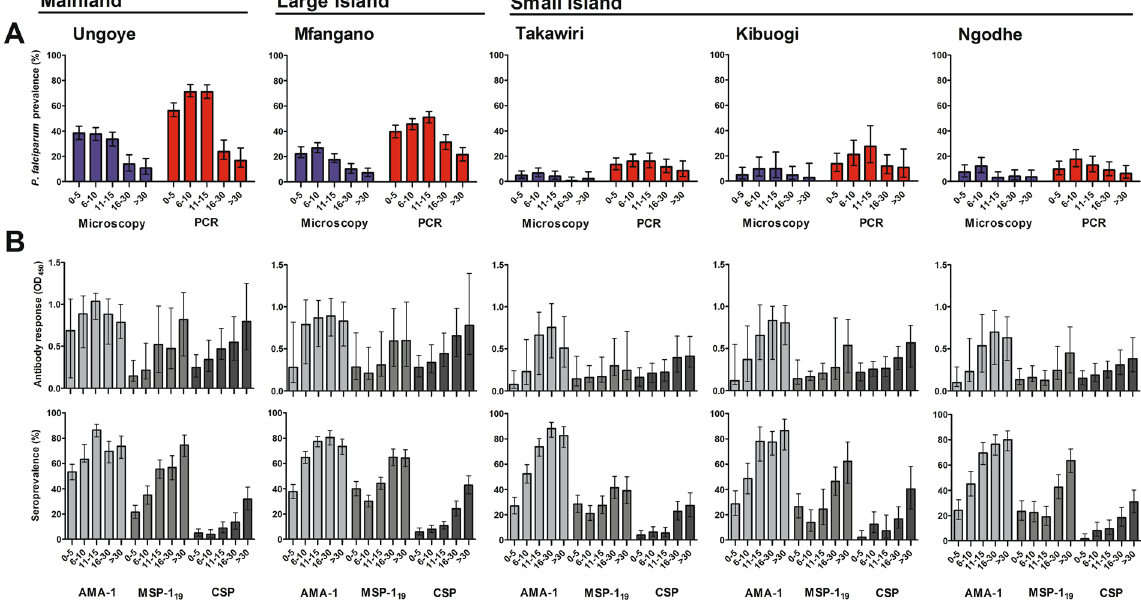
Figure 2. Age-specific prevalence of P . falciparum parasites and antimalarial antibody responses by setting. ( A ) The prevalence of P . falciparum (as determined by microscopy and PCR), and ( B ) optical density (OD) and respective seroprevalence to AMA-1, MSP-1 19 and CSP (as determined by ELISA) in each setting by age group. Data are shown for both surveys combined. The total numbers of sample tested were; microscopy, n = 5012; PCR, n = 4946; ELISA, n = 4112. Error bar represents 95% confidence interval (CI) or interquartile range (IQR, 25th – 75th